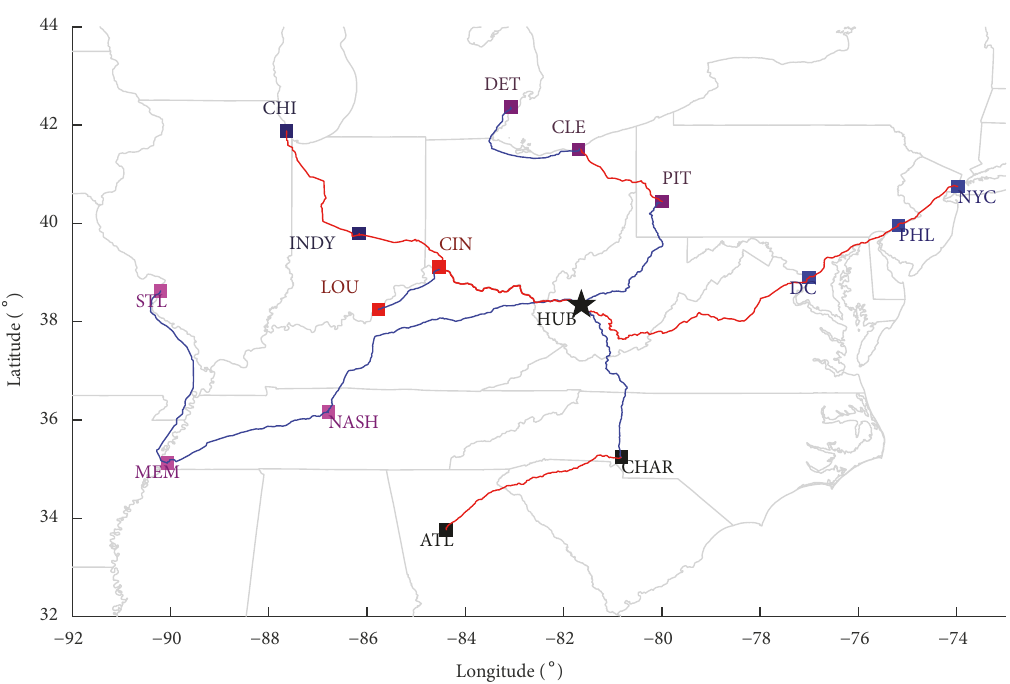
Figure 5: Solution 2 of mass transit system showing mode of transportation: red = train; blue =